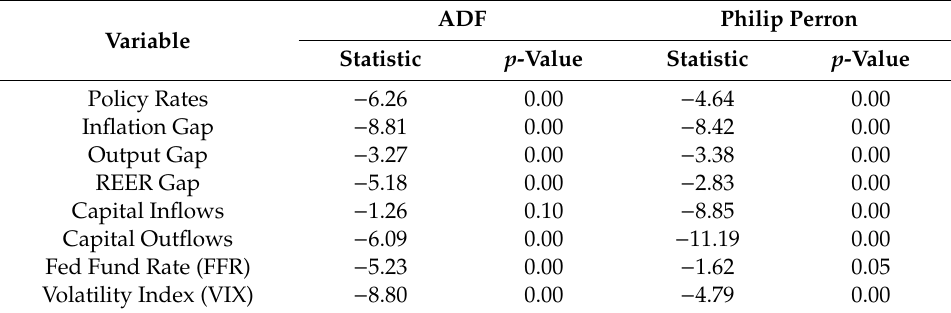
Table A3. Augmented Dicky–Fuller and Philip Perron Unit Root Test